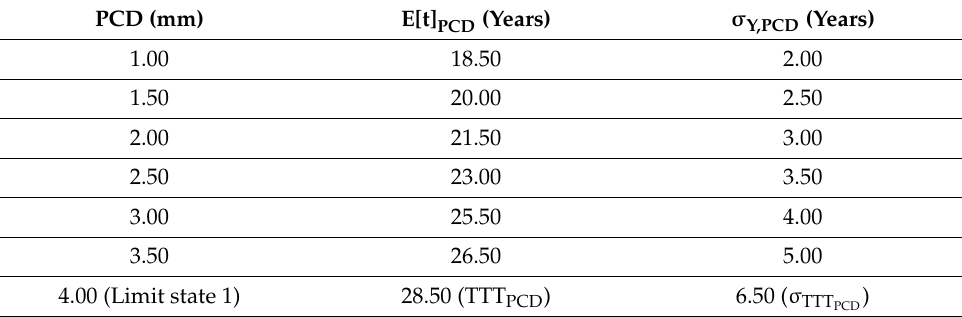
Table 12. The expected time E [ t ] corresponding σ Y,PCD .